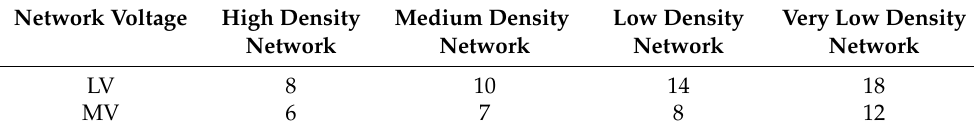
Table 5. Limits for the FIC indicator in Chile during the year